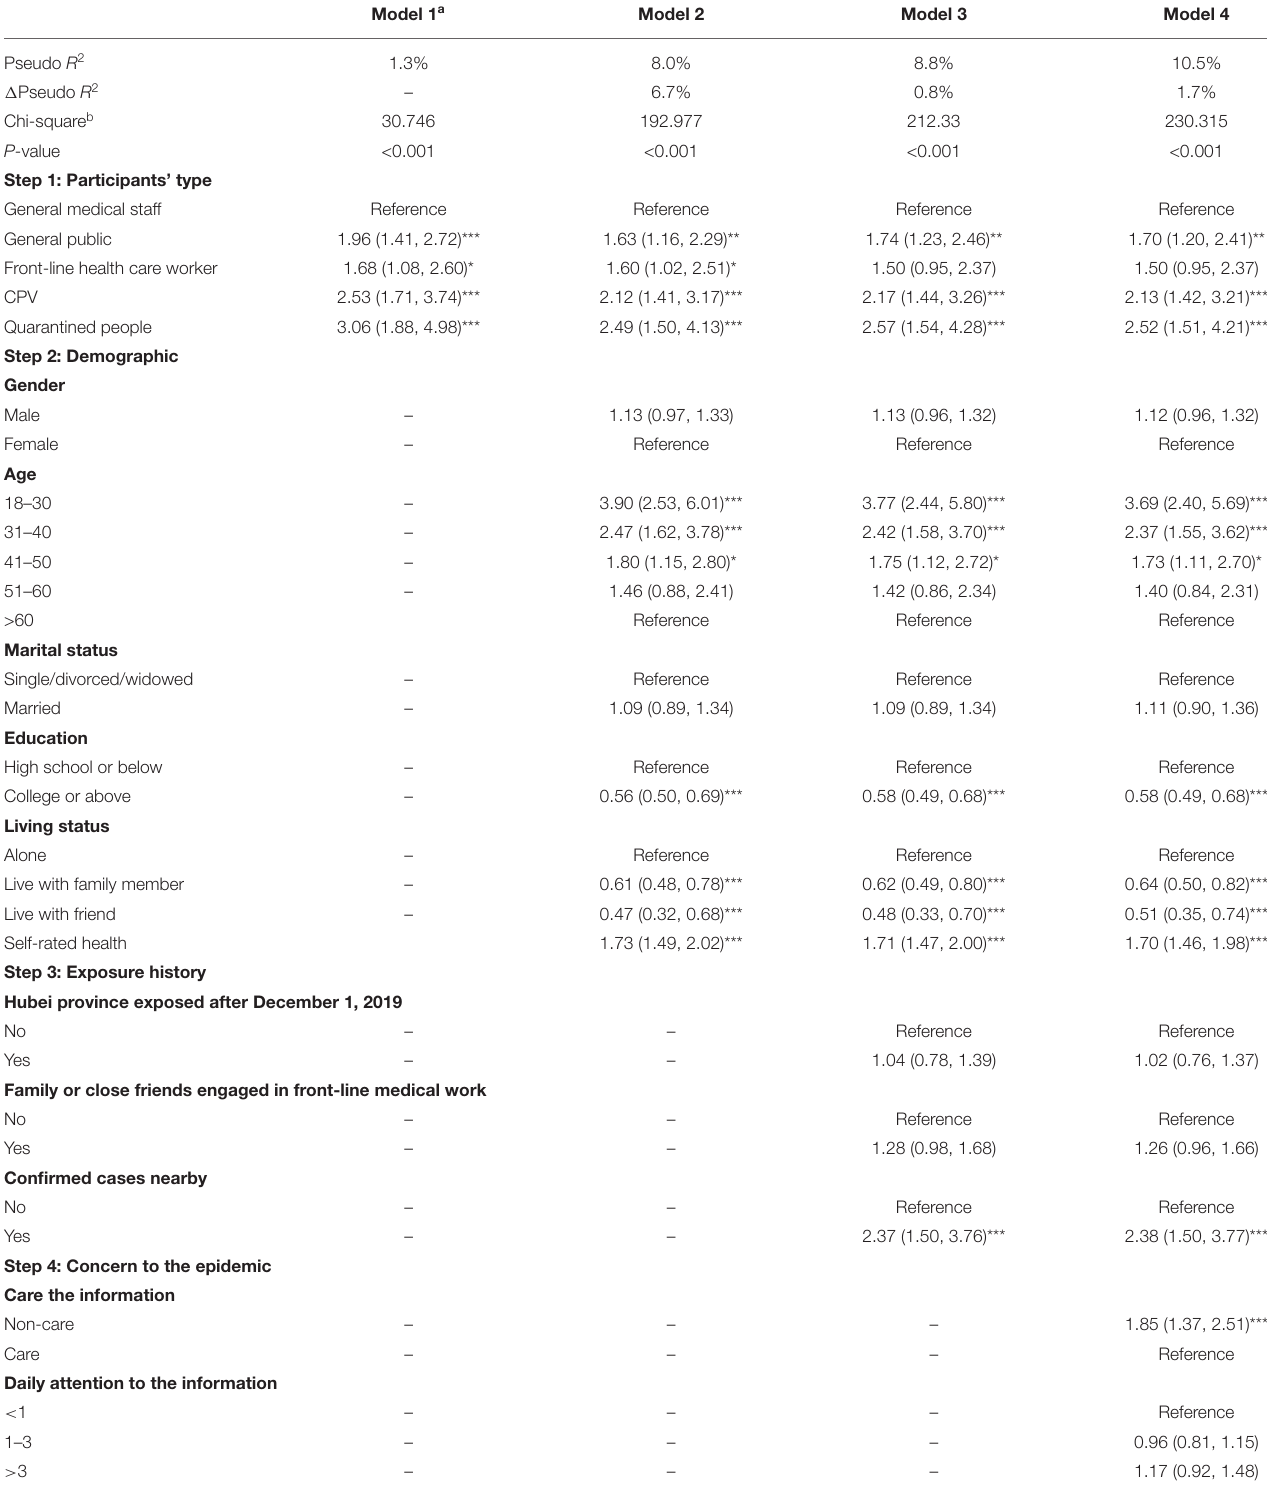
TABLE 3 | Multiple logistic regression analysis of factors associated with